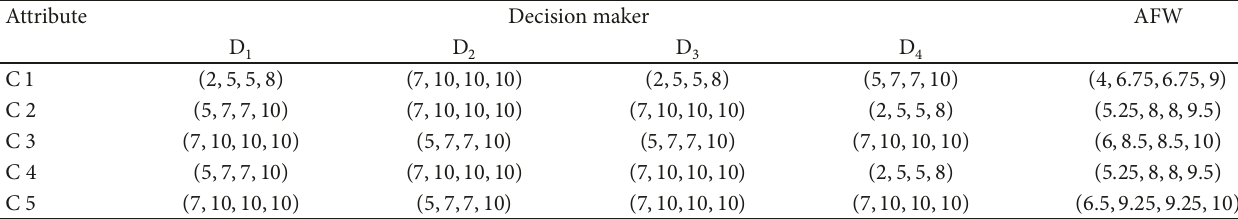
Table 4: Fuzzy weights and set fuzzy weights of